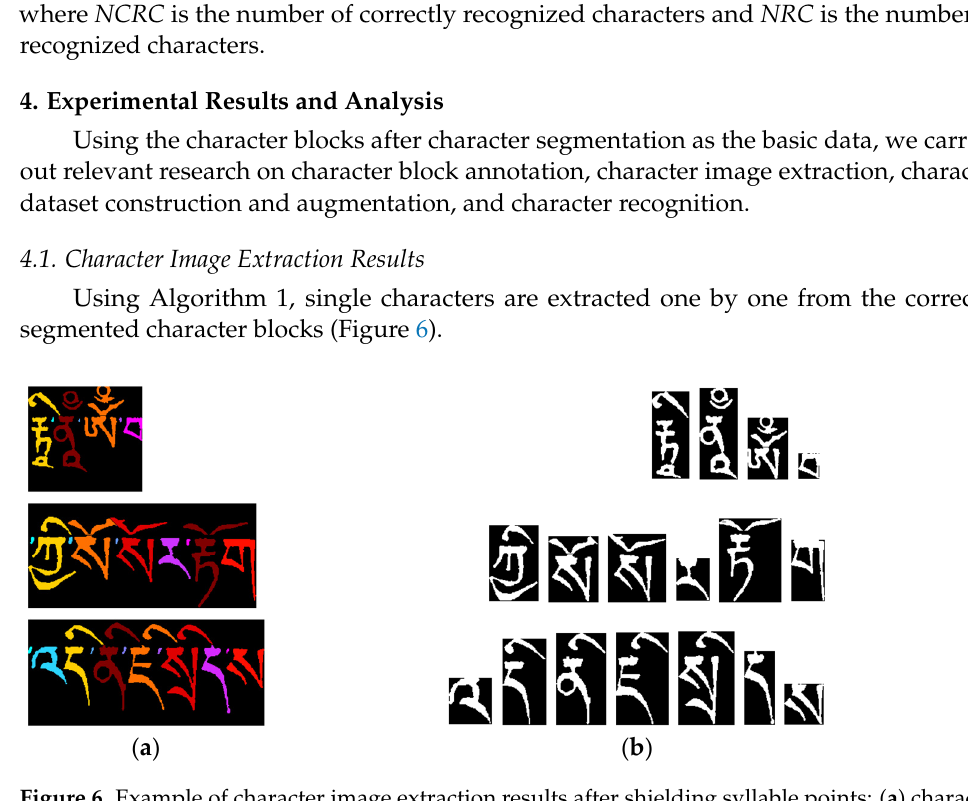
Figure 6. Example of character image extraction results after shielding syllable points: ( a ) character block after segmentation; ( b ) extracted characters (shielded syllable